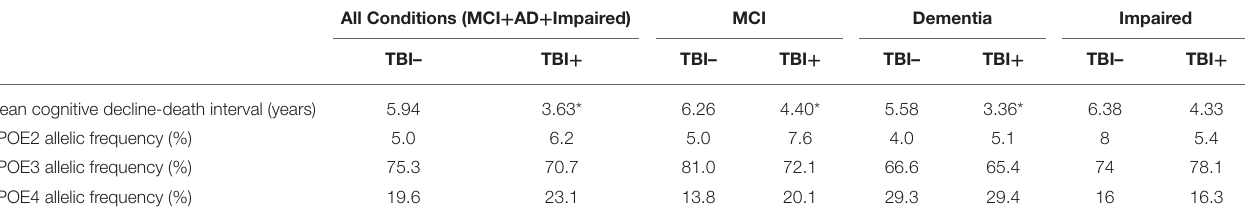
TABLE 2 | Cognitive decline-death intervals and allelic APOE frequencies in TBI + vs. TBI– subjects. All Conditions (MCI + AD +